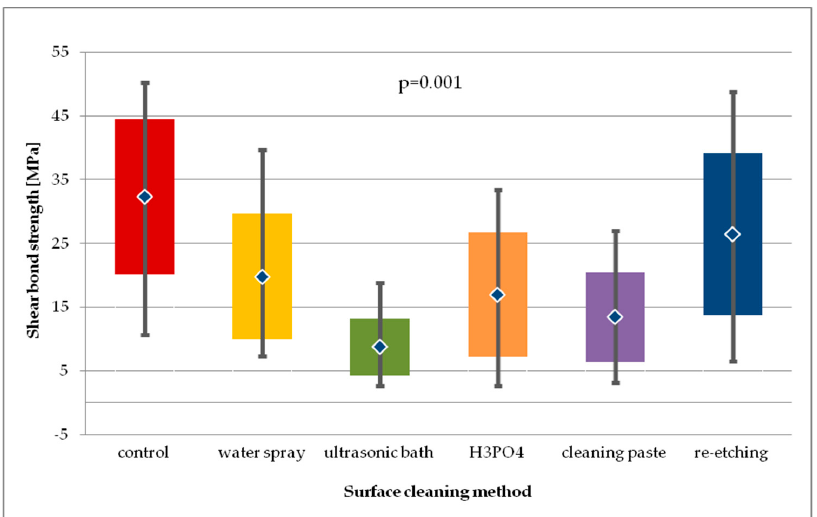
Figure 10. Shear bond strength of resin material to saliva contaminated lithium disilicate glass ceramics (LDGC) using different cleaning methods, after 24-hour water storage followed by